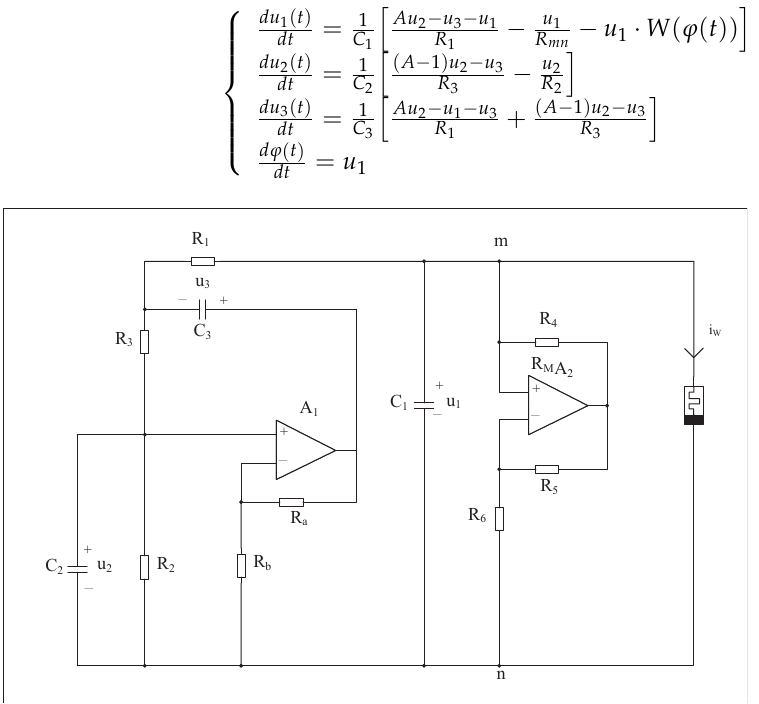
Figure 1. Chaotic circuit based on a quadratic smooth model of an SBT memristor The four state variables u 1 ( t ) , u 2 ( t ) , u 3 ( t ) , ϕ ( t ) in Equation (2) correspond to the voltage of the capacitor C 1 , the voltage of the capacitor C 2 , the voltage of the capacitor C 3 and the internal flux of the SBT memristor. Setting τ